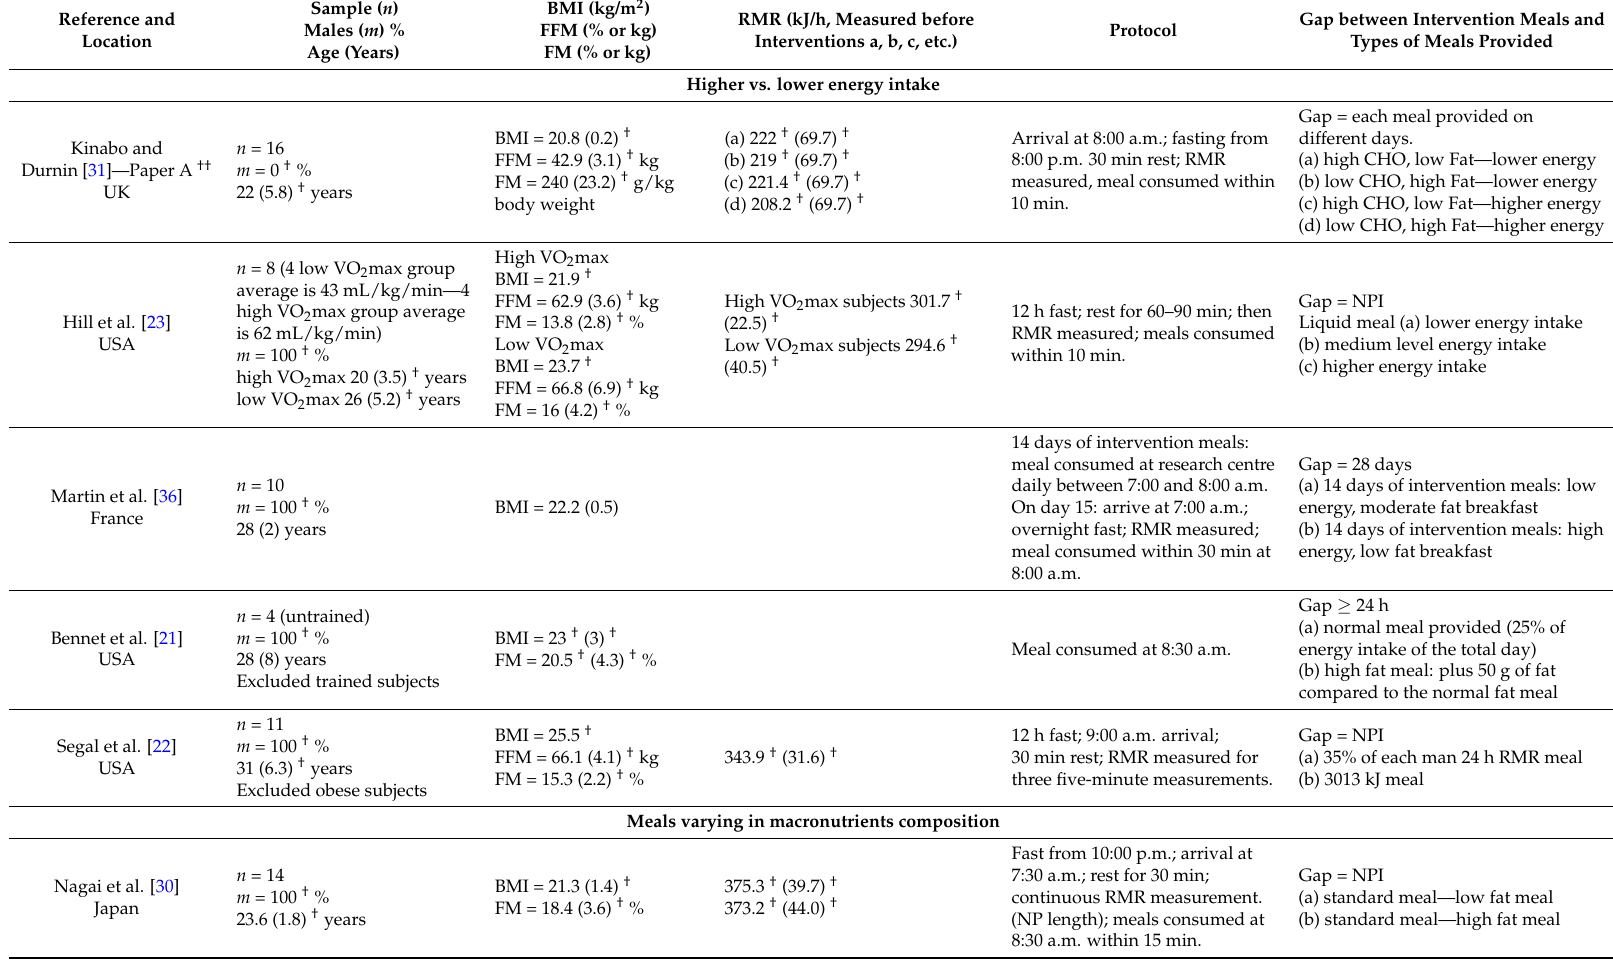
Table 1. Participant characteristics and study